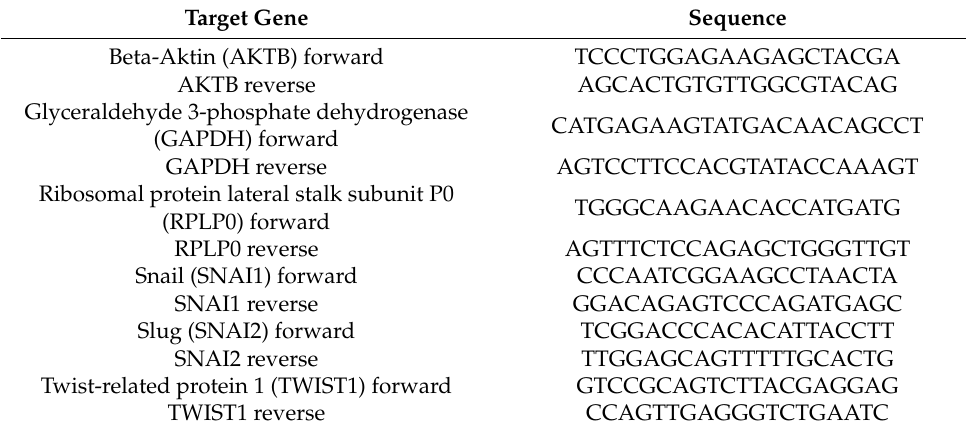
Table 2. Primers used for